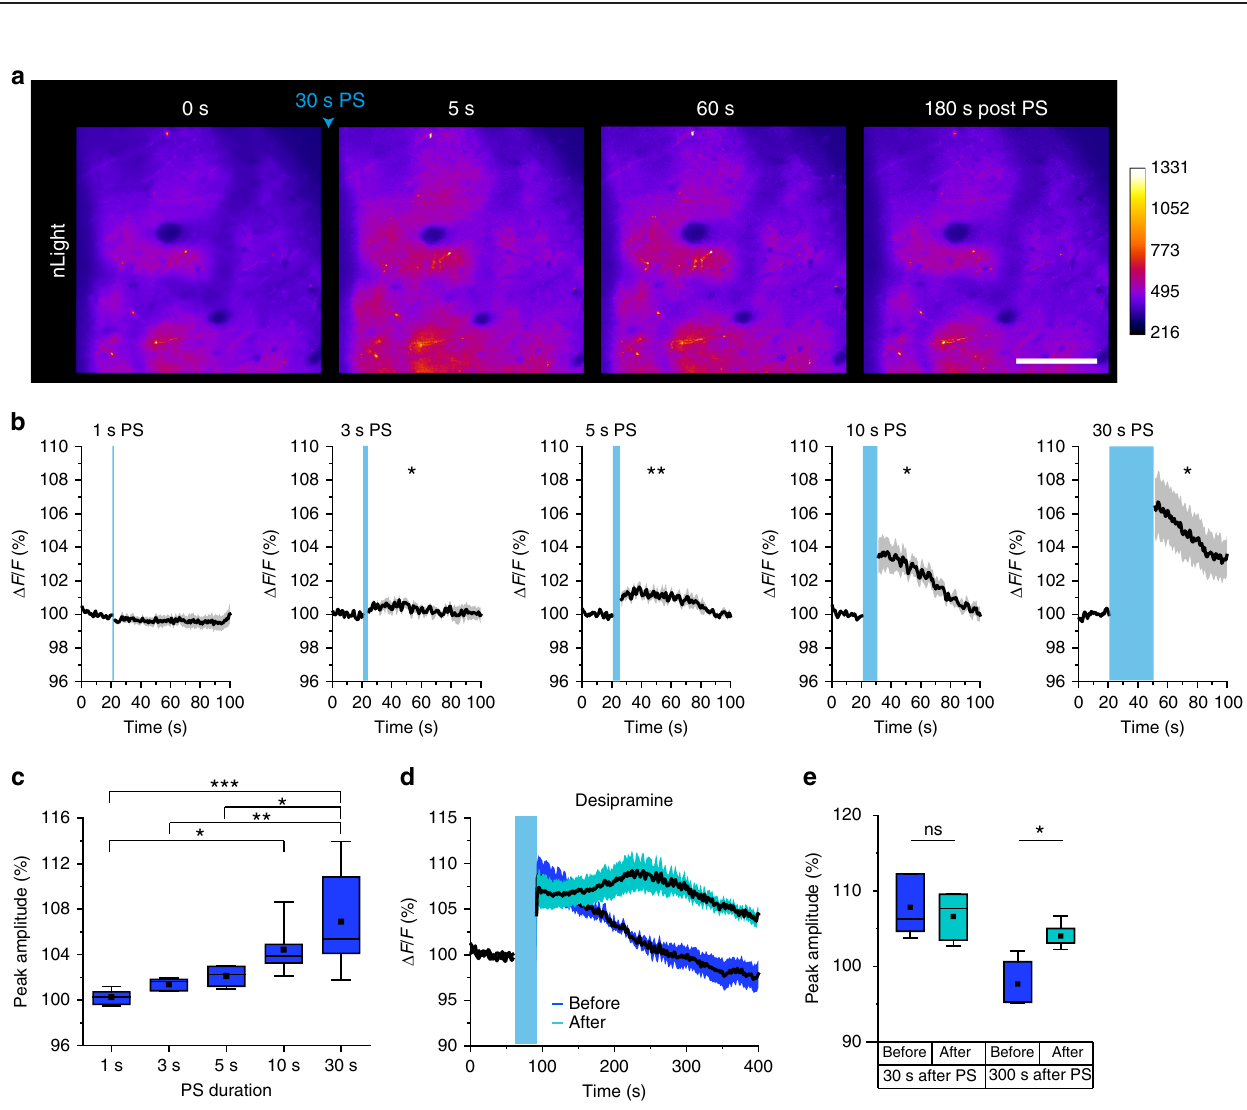
Fig. 2 LC/NA-driving PS duration is highly correlated with extracellular NA concentration in the cerebral cortex. a Representative cortical images of nLight before and after 30-s LA/NA axon PS. Scale bar: 100 μ m. b nLight responses by varying PS duration. Asterisks indicate signi fi cant differences of peak amplitude after PS compared with the basal signal ( n = 5 – 6 sessions, 4 mice). c Comparison of peak nLight response amplitude for the data in b ( n = 5 – 6 sessions, 4 mice). d , e nLight signals before and after desipramine injection (NA reuptake inhibitor, 10 mg/kg, i.p. 30 min before imaging). Traces represent mean ± SEM ( d ). Peak amplitude was quanti fi ed at 30 and 300 s after PS ( e , n = 5 sessions, 4 mice). Analysis was performed from the average of individual sessions. Box plots: box range, 25 – 50 – 75% quatile; square, mean; whiskers, max – min. One-way ANOVA with Turkey ’ s test: c ; paired t -test: b , d ; * p < 0.05, ** p < 0.01, *** p <